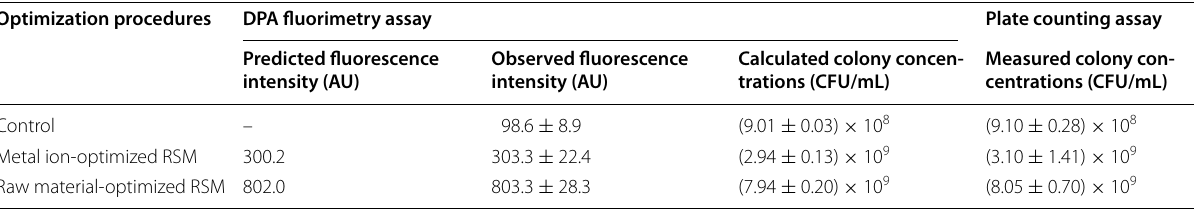
Table 6 Verification for spore production after two-step RSM optimization procedures Optimization